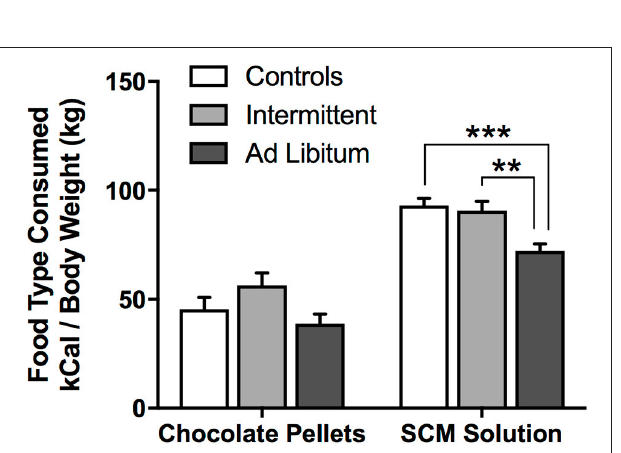
FIGURE 3 | Outcome calories consumed during the pre-feeding phase of the devaluation test. Immediately prior to the devaluation test, rats were given 1h access to either chocolate pellets or SCM solution. Their food consumption during this period is presented here as calories (kCal) adjusted to body weight (kg). Rats in the ad libitum group consumed the least amount of each outcome. Means ± SEM. ** p < 0.01, *** p < 0.001.